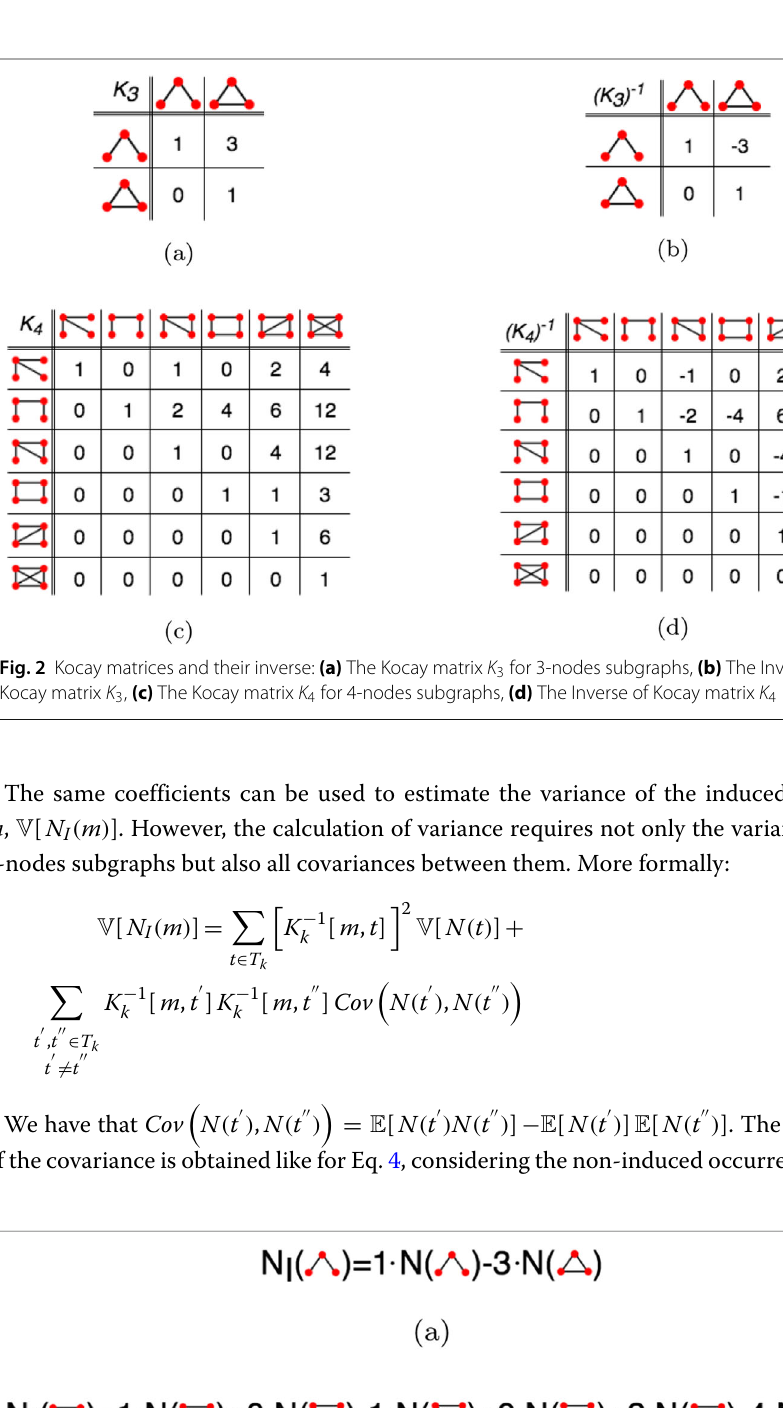
Fig. 3 Examples of application of Kocay Lemma. a Number of induced occurrences of the 3-nodes path as a linear combination of the non-induced counts of the 3-nodes path and the 3-nodes clique: the coefficients of the combination are the entries of the first row of matrix K − 1 3 (corresponding to the 3-nodes path), i.e. 1 and − 3, respectively. b The number of induced occurrences of the 4-nodes star expressed as a linear combination of the non-induced counts of all six 4-nodes subgraphs: the coefficients of the combination are the entries of the first row of matrix K − 1 4 (corresponding to the 4-nodes